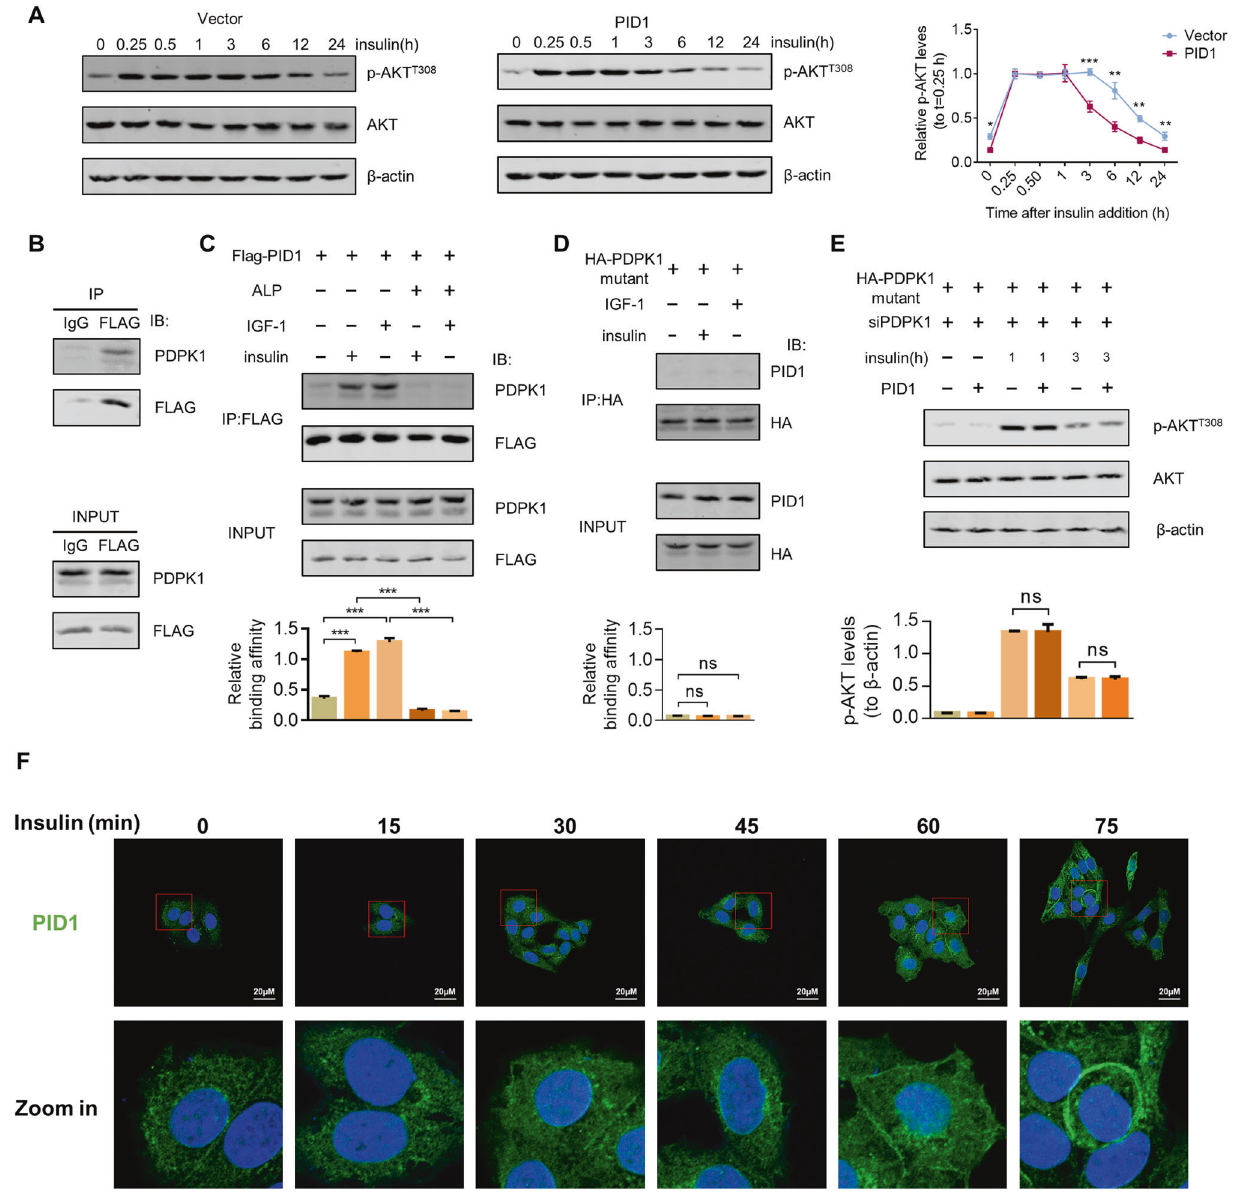
Fig. 4 PID1 inhibited continuous AKT activation via interacting with PDPK1 but facilitated IGF-1-induced survival signal. A Time-course analysis of AKT phosphorylation upon insulin (10 nM) treatment in HepG2 cells with or without PID1 overexpression. p-AKT T308 band density was normalized to actin and then normalized to t = 0.25 h. B Interaction between endogenous PDPK1 and FLAG-tagged PID1 was con fi rmed by co-immunoprecipitation assay. C Interaction between endogenous PDPK1 and FLAG-tagged PID1 upon indicated treatment was examined by co-immunoprecipitation assay. D Interaction between endogenous PID1 and HA-tagged PDPK1 mutant (Y9, 373 and 376 F) upon indicated treatment was examined by co-immunoprecipitation assay. E Western blot analysis of AKT, p-AKT T308 and β -actin in HepG2 cells with indicated treatment was performed. F Immuno fl uorescence staining of PID1 in Hep3B cells upon treatment of insulin for indicated time. Merged images show the overlap of PID1 (green) and nuclear staining by DAPI (blue). Data are expressed as mean ± SD ( n = 3). * p < 0.05; ** p < 0.01, *** p < 0.001; ns not signi fi